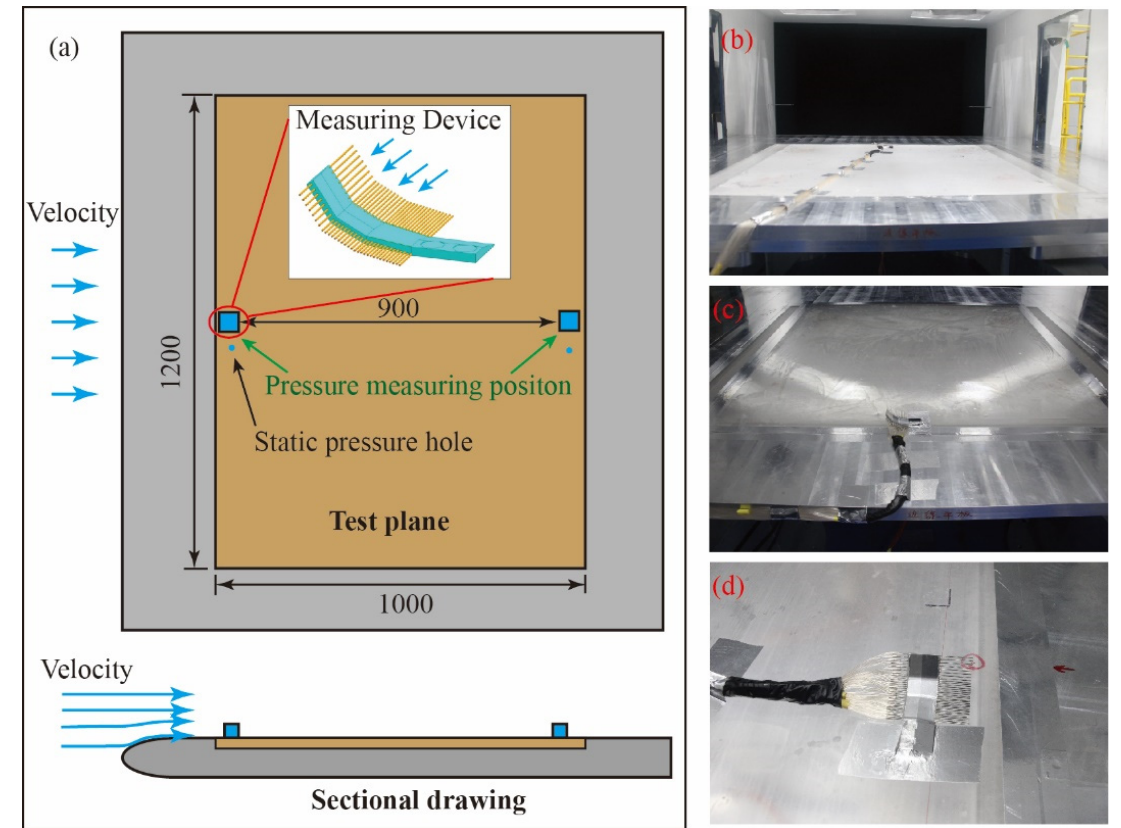
Figure 6. The experiment setup for the plate model: ( a ) the sketch of wind tunnel experiment for plate model; ( b ) pressure measuring at the front of the plate; ( c ) the pressure measuring at the rear of the plate; ( d ) the pressure-measuring device used in the experiments.